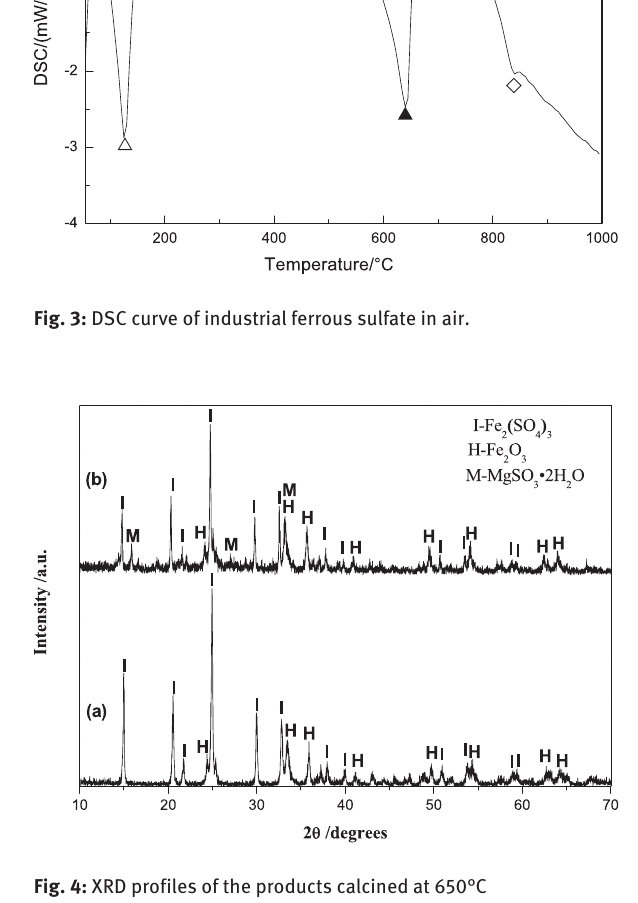
Fig. 4: XRD profiles of the products calcined at 650°C (a) conventional calcinations and (b) microwave calcinations.